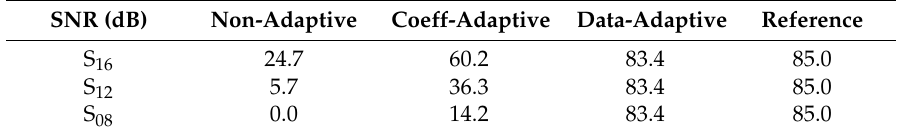
Table 3. Signal-to-noise ratio (SNR) Performance of the demodulator–input quantization excluded.